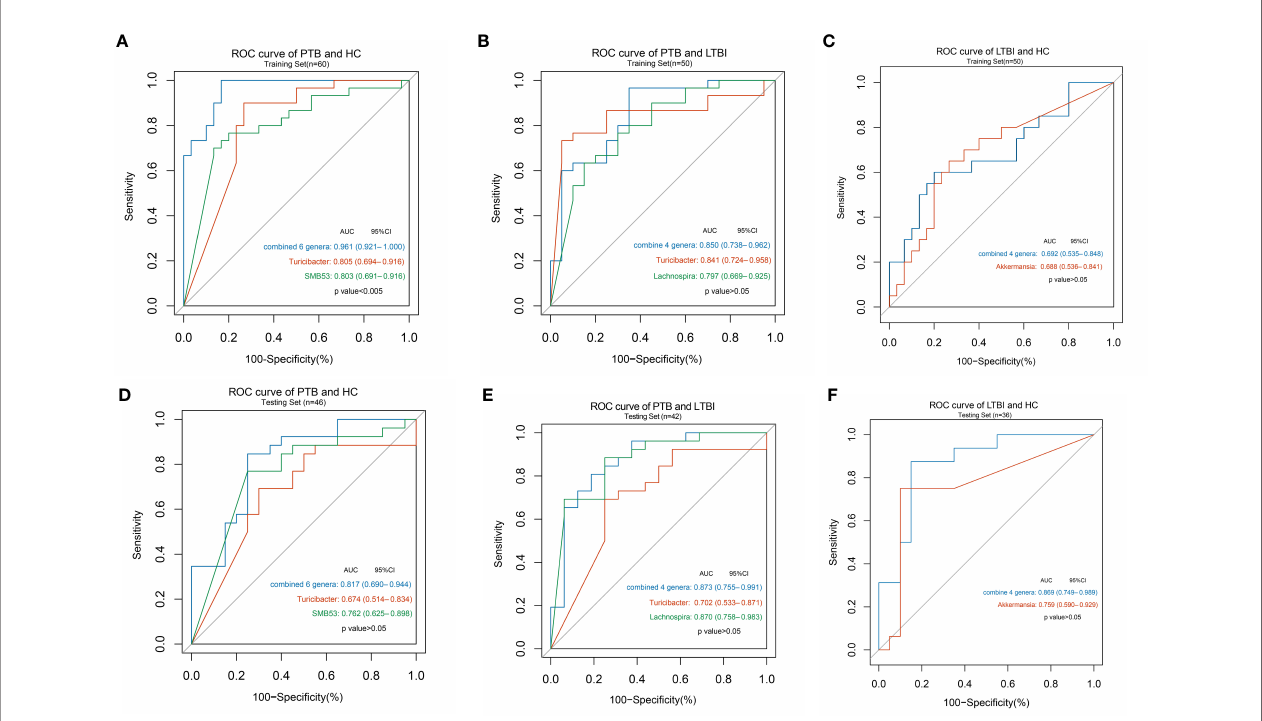
FIGURE 4 | Disease states classi fi cation based on gut microbiome signature. Classi fi cation performance of random forest models by ROC for training set (A) in PTB and HC groups (n = 30 and 30); (B) in PTB and LTBI groups (n = 30 and 20); (C) in LTBI and HC groups (n = 20 and 30) and for testing set; (D) in PTB and HC groups (n = 26 and 20); (E) in PTB and LTBI groups (n = 26 and 16); (F) in LTBI and HC groups (n = 16 and